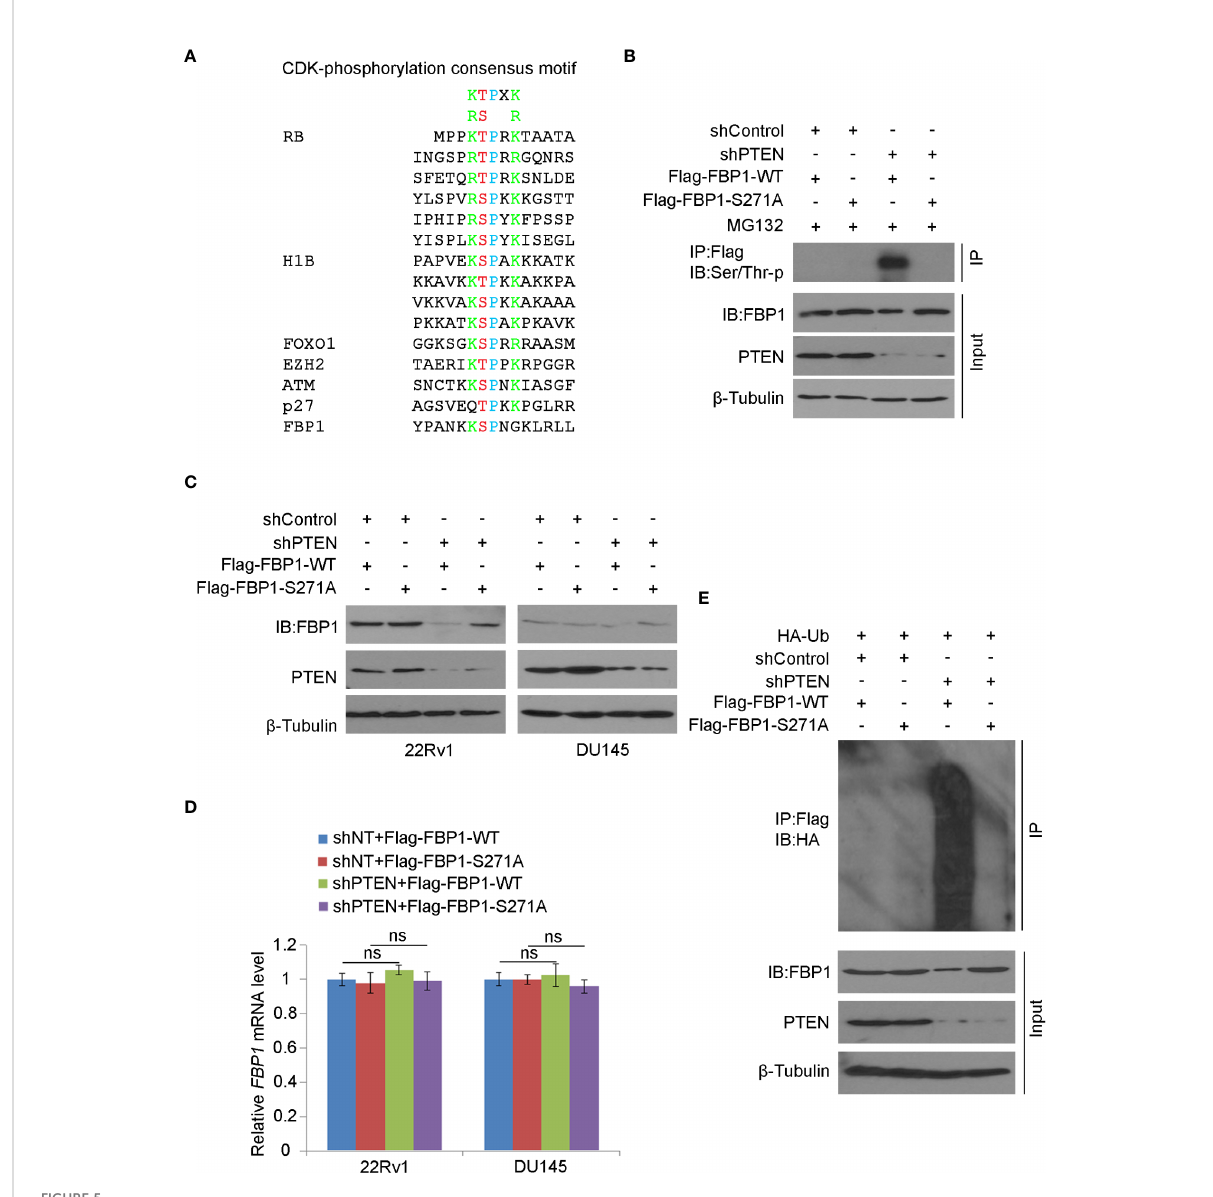
FIGURE 5 Serine 271 phosphorylation is important for FBP1 degradation induced by PTEN loss (A) Amino acid sequence alignment among CDK phosphorylation consensus motif, those identi fi ed in known CDK substrates, and the putative CDK phosphorylation site (serine 271) on FBP1. (B) WB analysis in the whole cell lysate and co-IP samples in 293T cells transfected with indicated plasmids or infected with indicated lentivirus for 48 hours. (C, D) WB (C) and quantitative RT-PCR (D) analyses were performed in 22Rv1 and DU145 cells infected with lentivirus expressing control or PTEN-speci fi c shRNAs and/or transfected with plasmid for Flag-tagged FBP1 WT or S271A for 48 hours. All quantitative data are shown as Mean ± SD (n=3). Student ’ s t test. n.s., not signi fi cant. (E) WB analysis was carried out using the whole cell lysate and co-IP samples in 293T cells transfected with indicated plasmids or infected with indicated lentivirus for 48